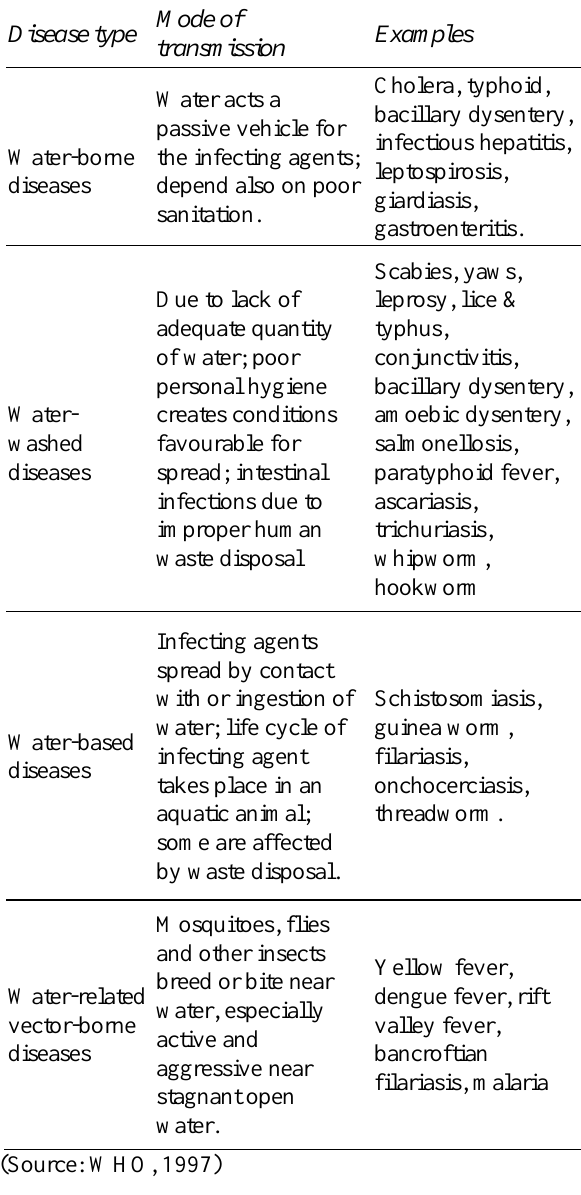
Table 2: Diseases transmitted through